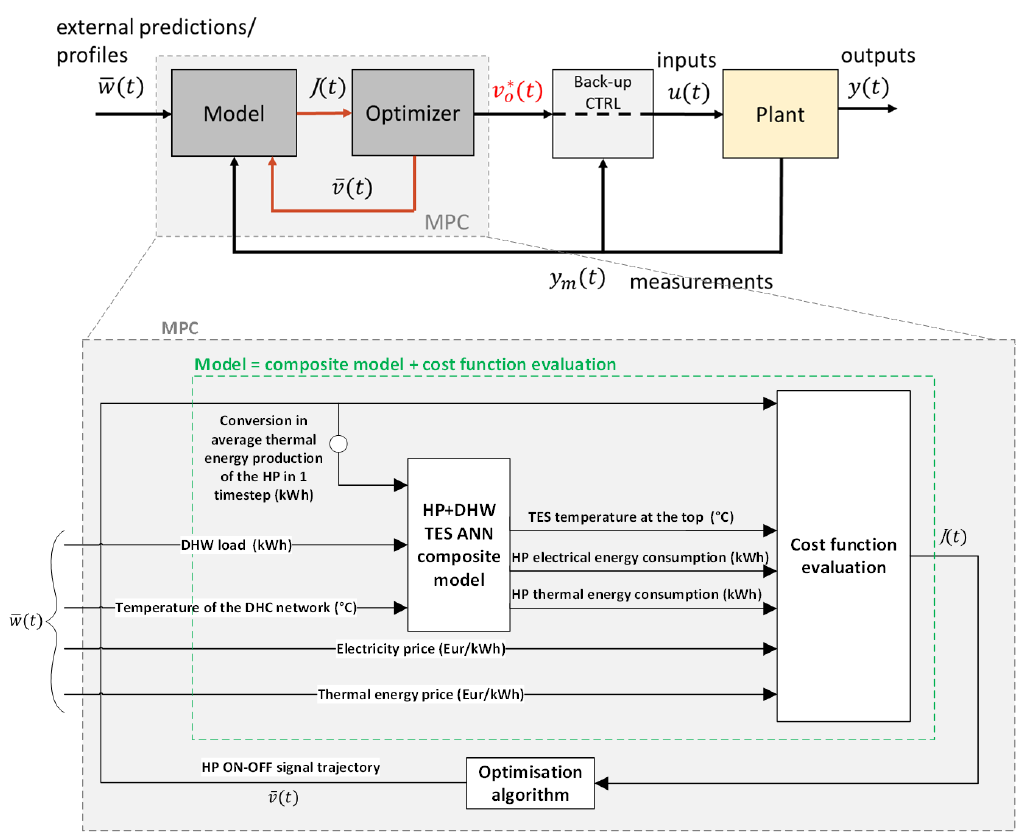
Figure 10. Block diagram of the controller ( top ) with a focus on the MPC implementation ( bottom ).